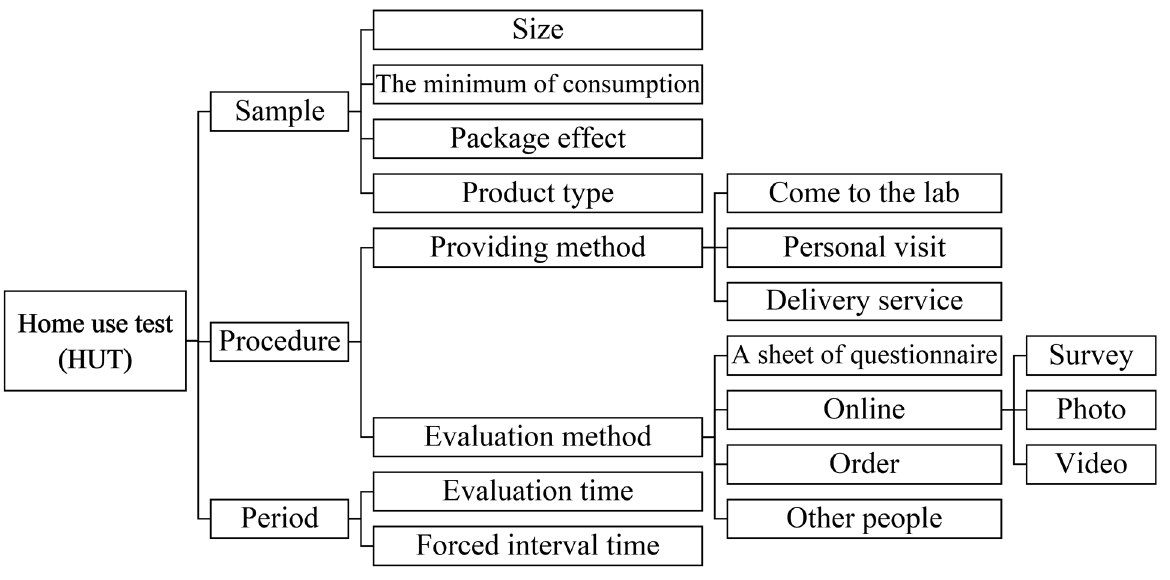
Figure 1. Summary of external factors in home use test (HUT).